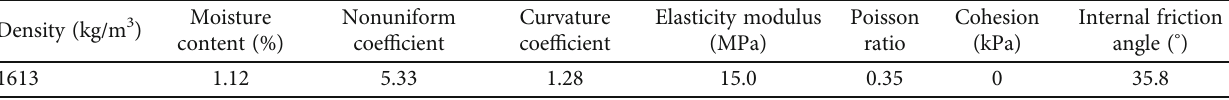
Table 5: The performance indexes of